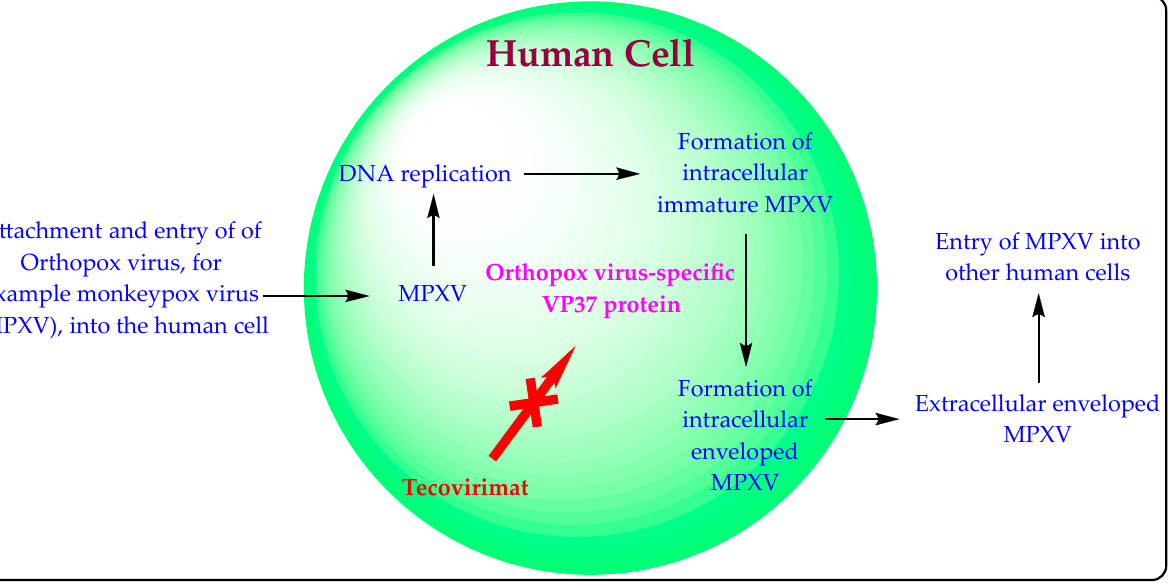
Figure 3. Mechanism of action of Tecovirimat.